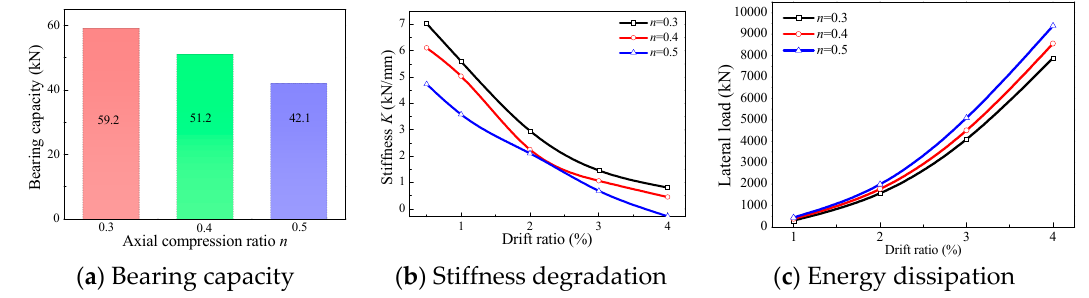
Figure 17. The e ff ect of the axial compression ratio. Figure 17. The effect of the axial compression Table 3. The parameters of the columns for numerical analysis.